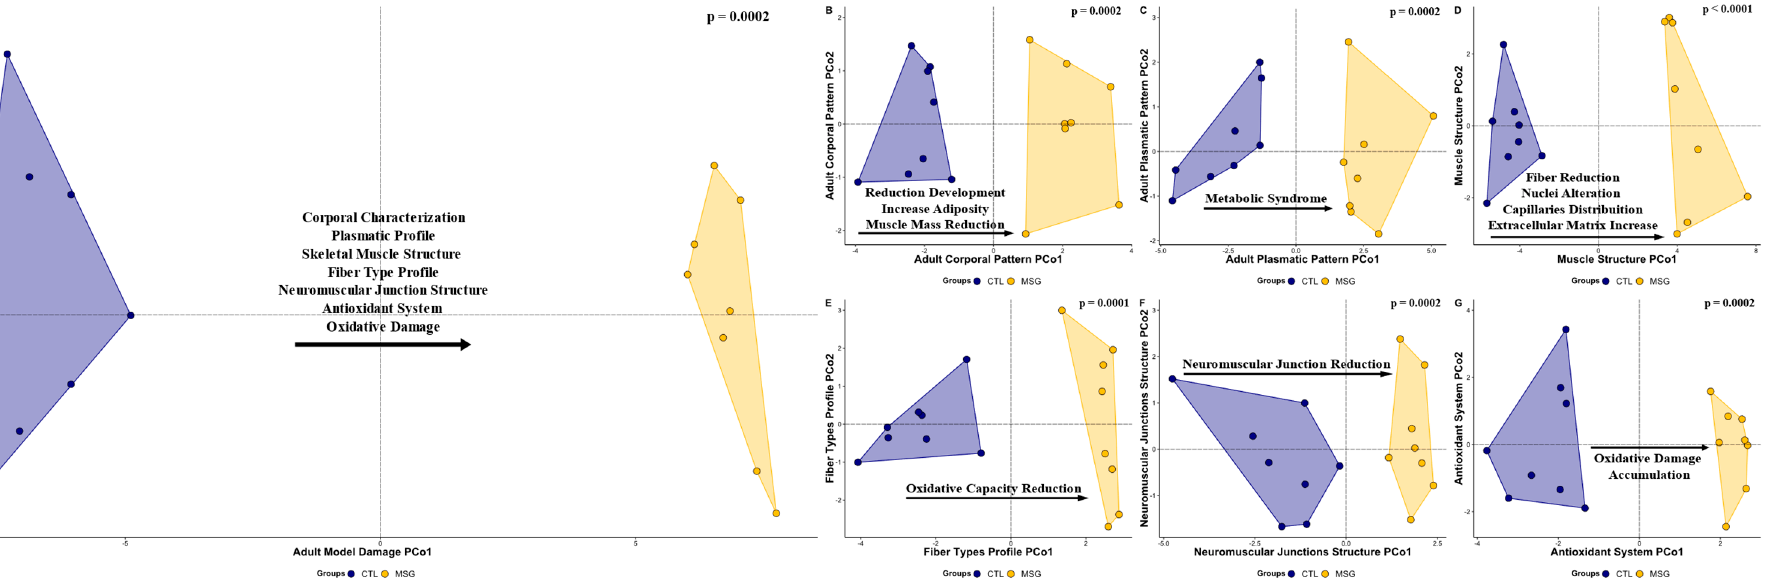
Figure 12. Graphical representation in scatterplot form of the multivariate relationships of the principal coordinates analysis (PCoA) of the animals to the PND142. ( A ): General Model Damage (all data); ( B ): corporal pattern; ( C ): plasmatic pattern; ( D ): skeletal muscle structure; ( E ): fiber types profile; ( F ): neuromuscular junctions structure; ( G ): antioxidant system. The CTL group is represented in blue and MSG group is represented in yellow All data: principal coordinates analysis.